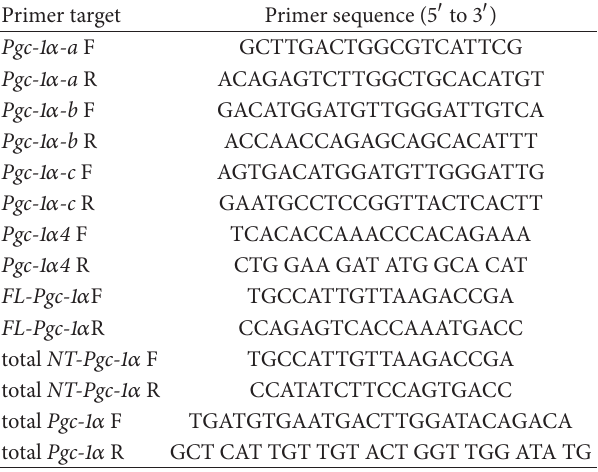
Table 1: Pgc-1 𝛼 isoform primer pair sequences are shown for the forward(F)andreverse(R)primersusedtomeasureisoformexpres- sion via qRT-PCR. Primer pairs have previously been reported by Miura et al. 2008, Ruas et al. 2012, and Zhang et al. 2009.